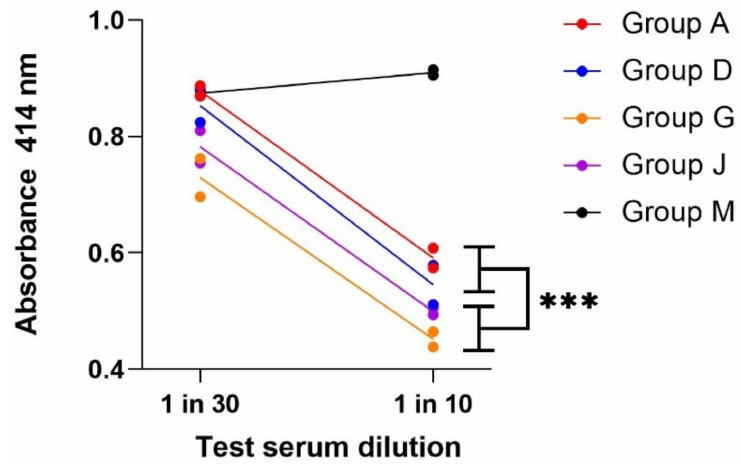
Figure 2. Competitive ELISA to determine the ability of day 35 sera, pooled by treatment group, to displace Mab7.3 from binding to V antigen. Pooled sera from each treatment group were assayed in duplicate in the dilution range 1:5 to 1:100 for their ability to displace 80 ng biotinylated Mab7.3 from V antigen, coated to solid phase. Pooled sera from group M provided the negative control. The OD 414nm was provided by streptavidin peroxidase detection of the biotinylated Mab7.3 and decreased as the test serum concentration increased. Group A: F1+V/alhydrogel; group D: F1+ V/PCMC/alhydrogel; group G: F1-V/alhydrogel; group J: F1-V/PCMC/alhydrogel; group M: PBS. These data were analysed using a three-parameter (serum dilution, vaccine formulation and type) analysis of variance with Bonferroni’s post test, using the software GraphPad PRISM V8.0. *** Group G sera were significantly more effective at displacing biotinylated Mab7.3 than are sera from Group A p <